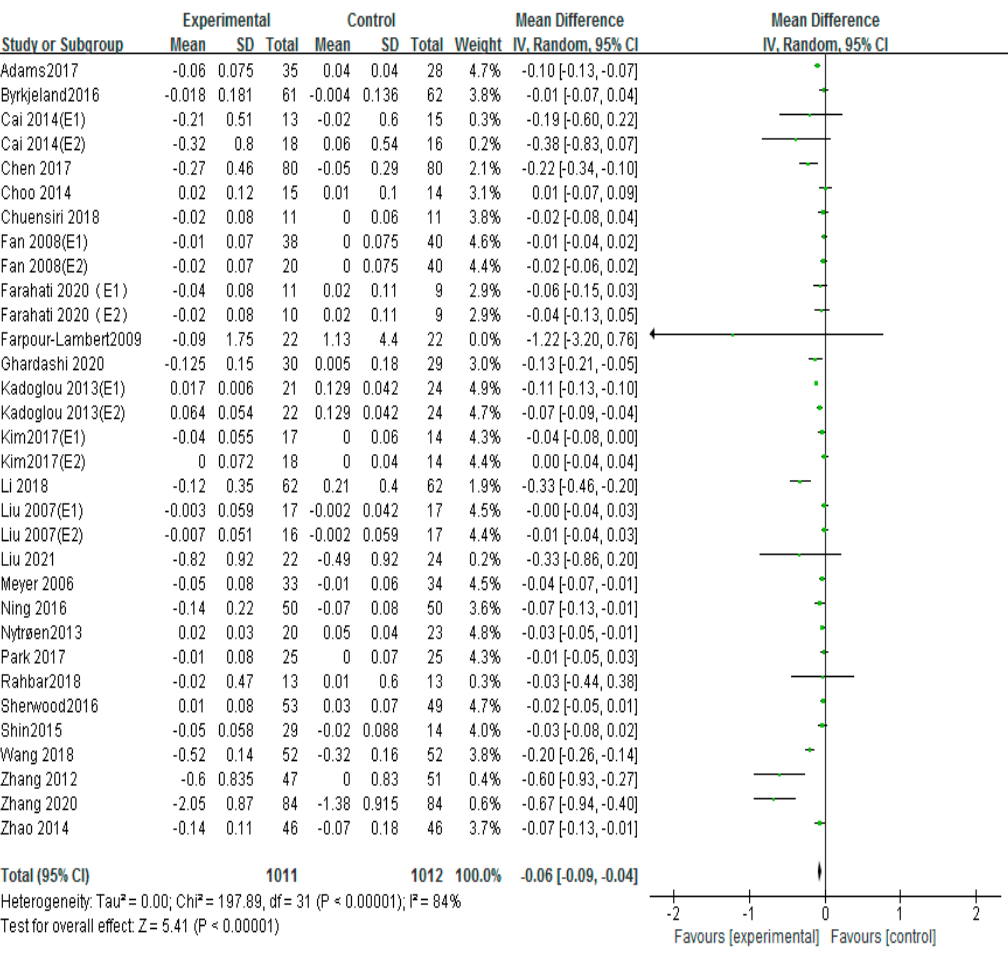
Figure 4. Meta − analyses of the effect of exercise on cIMT compared with the control group [12–15,17–